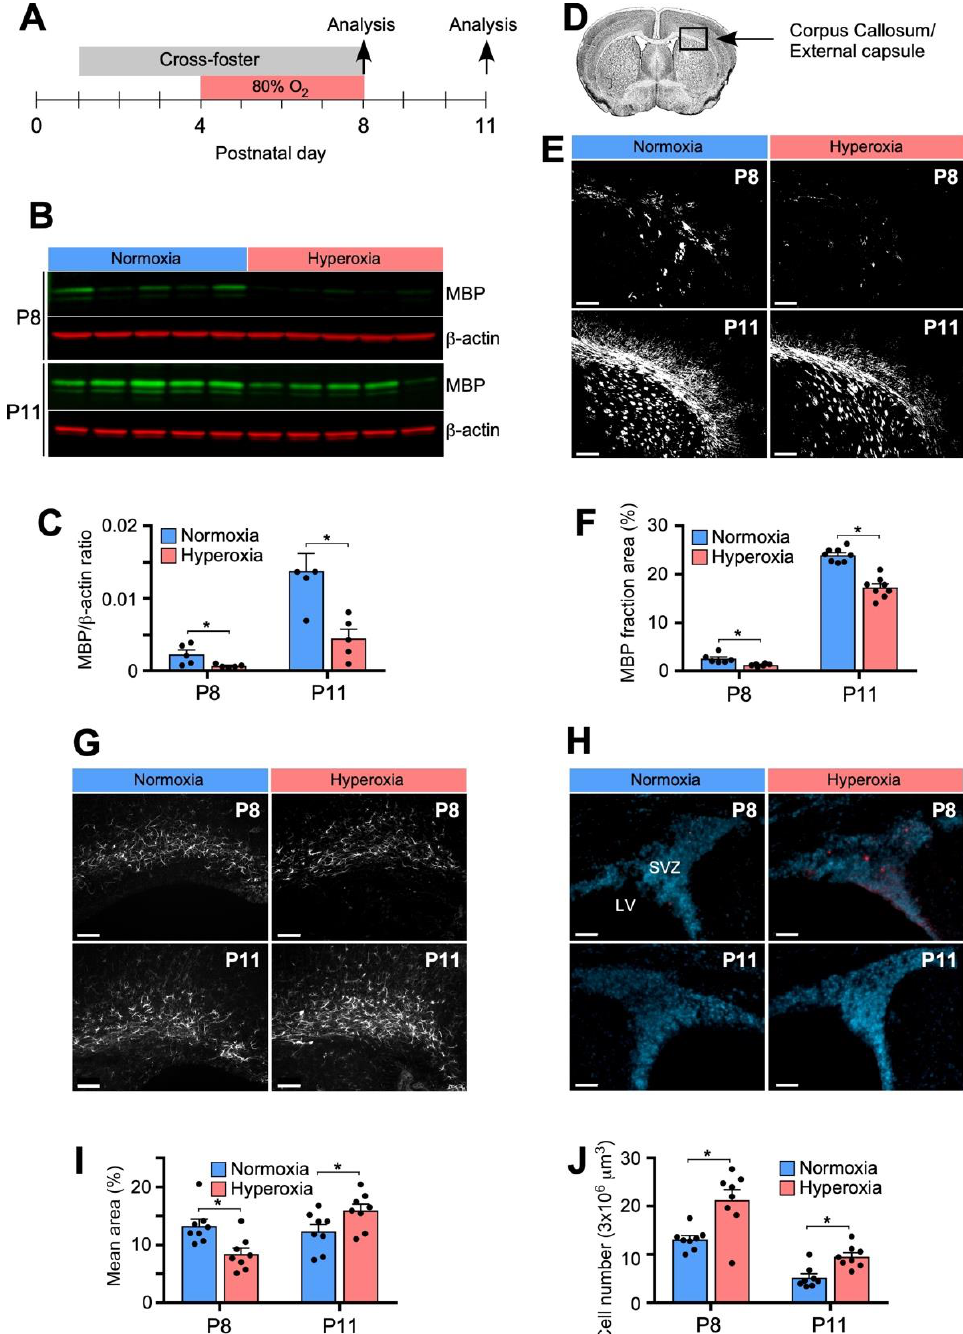
Figure 1. Hyperoxia induced model of periventricular leukomalacia (PVL). ( A ) Schema for two C57Bl/6J mice litters that were cross-fostered from P1; half of the litters were exposed to hyperoxia (80% oxygen) and half remained in normoxia (room air) from P4-P8. ( B ) Western blots for MBP and β -actin at P8 and P11. ( C ) Densitometric analysis of MBP normalized to β -actin showed decreased protein expression at P8 and P11. ( D ) Region of the Corpus Callosum/External Capsule imaged for immunohistochemical staining. ( E ) Representative fluorescent images (5 × ) of MBP immunohisto- chemical staining at P8 and P11. Consistent exposure and threshold parameters between groups were used during imaging and analysis. Scale bar = 200 µ m. ( F ) Quantification of myelin basic protein (MBP) immunofluorescence as mean percent area showed decreased MBP staining at P8 and P11. ( G ) Hyperoxia is associated with altered GFAP immunoreactivity and cellular apoptosis within the SVZ. Representative fluorescent images (20 × ) of GFAP-stained brain sections at P8 and P11 in